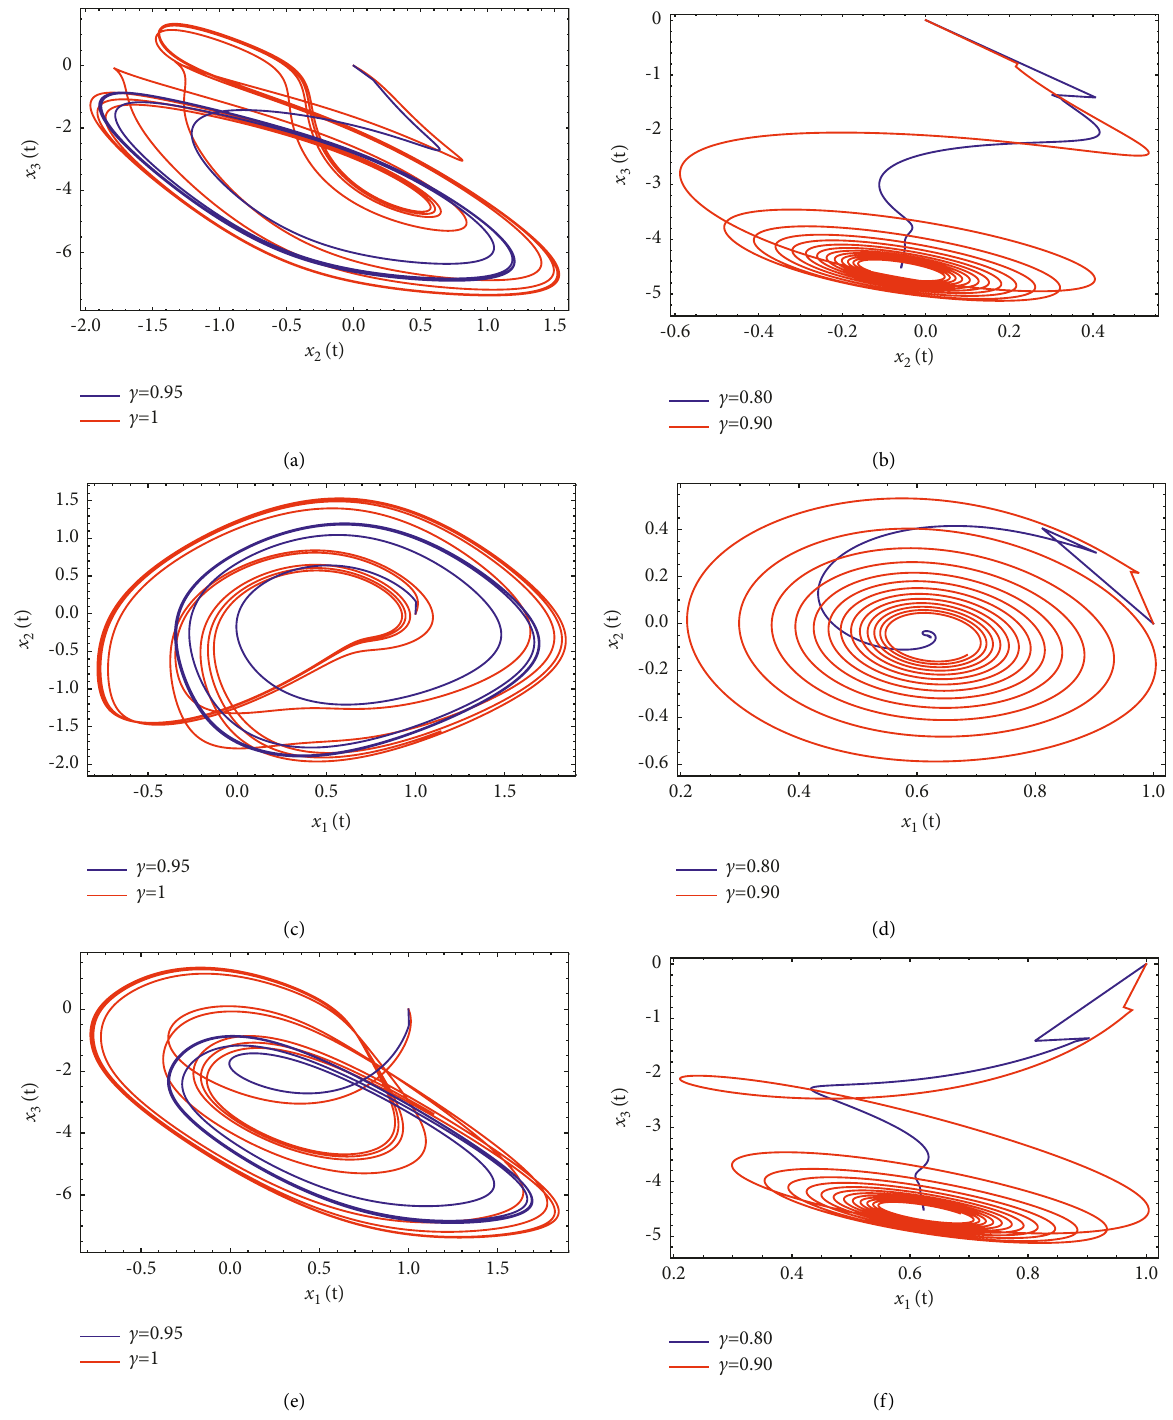
Figure 1: Dynamics of coexisting multiple attractors’ for gradient β (a) State variables x 2 versus x 3 ; (b) state variables x 2 versus x 3 ; (c) state variables x 1 versus x 2 ; (d) state variables x 1 versus x 3 ; (e) state variables x 1 versus x 2 ; (f) state variables x 1 versus x 3